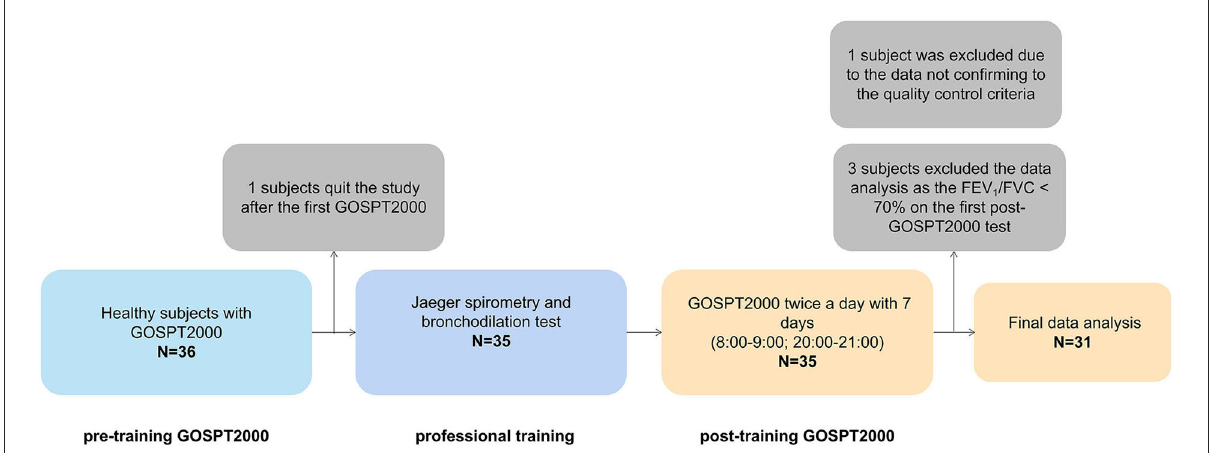
FIGURE1 Schematic presentation of study design. A total of 36 adults were invited to participate, among which one participant quit the study after conducted the first GOSPT2000 test and 35 adults attended and completed the 7-day portable spirometer and laboratory pulmonary function tests; of these, three participants were excluded from the data analysis as their FEV 1 /FVC was < 70% on the first GOSPT2000 test, and one person was excluded from final analysis as data did not meet the quality control criteria, leaving 31 participants for the final data analysis in the present study. After the first portable GOSPT2000 test, the subjects were asked to complete the spirometry and bronchodilation test using a Jaeger spirometer under the guidance of a trained medical technician on the same morning. The quiescent period between measurements was 20 mins after completing the spirometry and bronchodilation test. Then, the subjects took the GOSPT2000 device home and completed the pulmonary function monitoring in the home setting for the next 7 consecutive days. FVC, forced vital capacity; FEV 1 , forced expiratory volume in 1s; FEV 3 , FEV in 3s; MEF50: forced expiratory flow at 50% of forced vital capacity; MEF25, forced expiratory flow at 75% of forced vital capacity; MMEF, forced expiratory flow between 25 and 75%; PEF, peak expiratory flow; SD, standard deviation; CI, confidence interval; t-, total; m-, morning; e-,